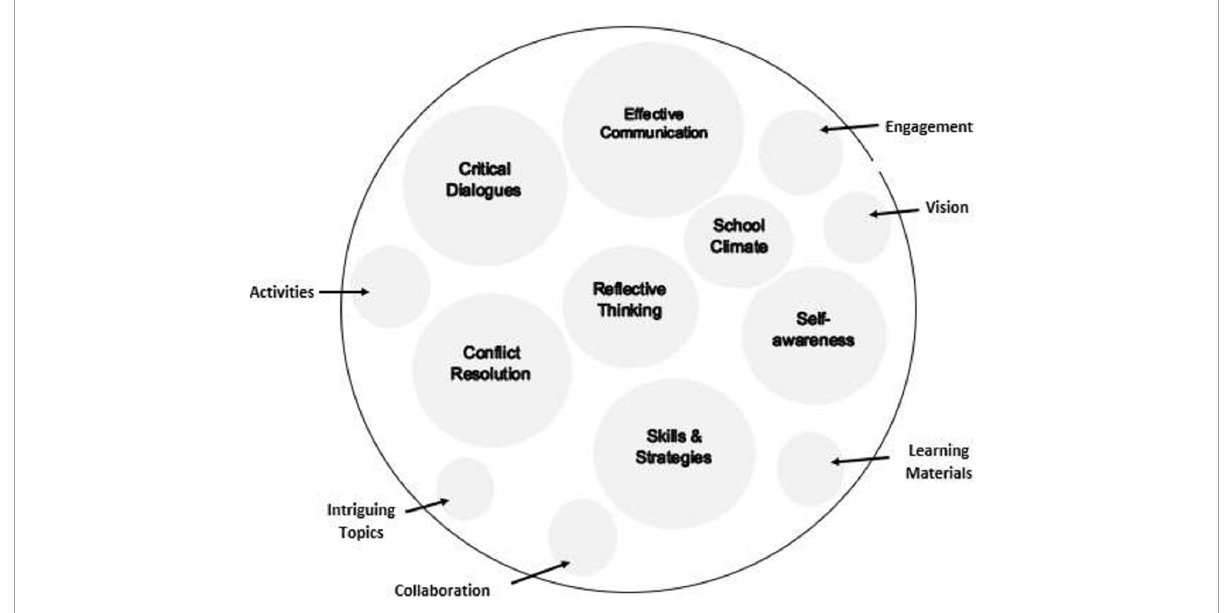
FIGURE1 Participants’ perceptions of the effective aspects of VPD on conflict